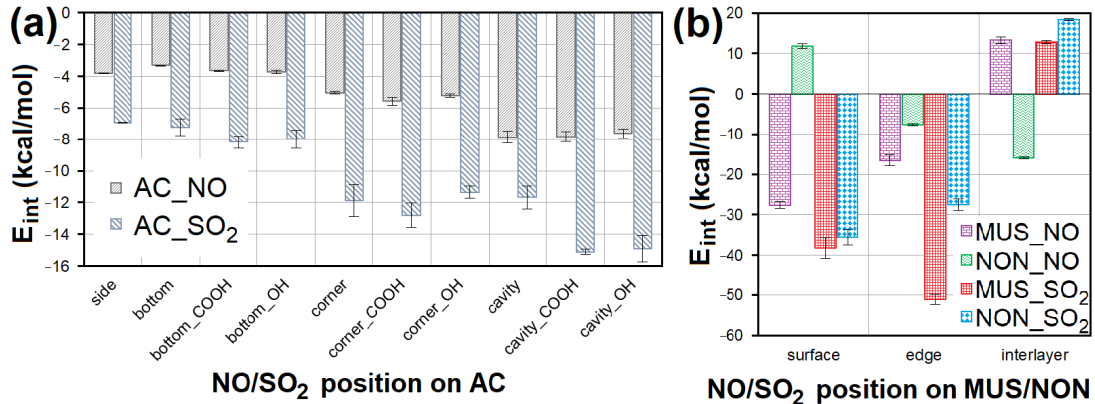
Figure 13. The E int comparison of models containing NO/SO 2 at different sites of ( a ) AC surface without or with -COOH/-OH groups and ( b ) MUS/NON surfaces. AC — activated carbon, MUS — muscovite, NON — nontronite, E int — interaction energy.